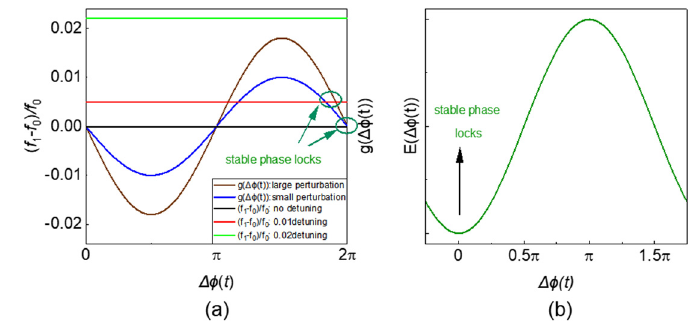
Figure 7. ( a ) Graphical solutions of first-order injection locking range and phase; ( b ) relationship between system’s energy and phase difference. Assuming that there are two LC oscillators with the same oscillation frequency, It can be seen from Equation (22) that, if K ij is positive, which means that there is a positive coupling between oscillators, the system’s energy reaches the minimum when φ i ( t ) − φ j ( t ) = 0, and their phases will tend to be the same (Figure 8a). However, if K ij is negative, which means that there is a negative coupling between oscillators, the energy takes the minimum value when φ i ( t ) − φ j ( t ) = π , and their phases will tend to be opposite (Figure 8b). When multiple oscillators are interfaced to each other through negative coupling, the phase of each oscillator and its neighbors tend to be opposite, and their phases cannot stay binary (0/ π ) under mutual interaction (Figure 8d). In this case, SHIL is required.